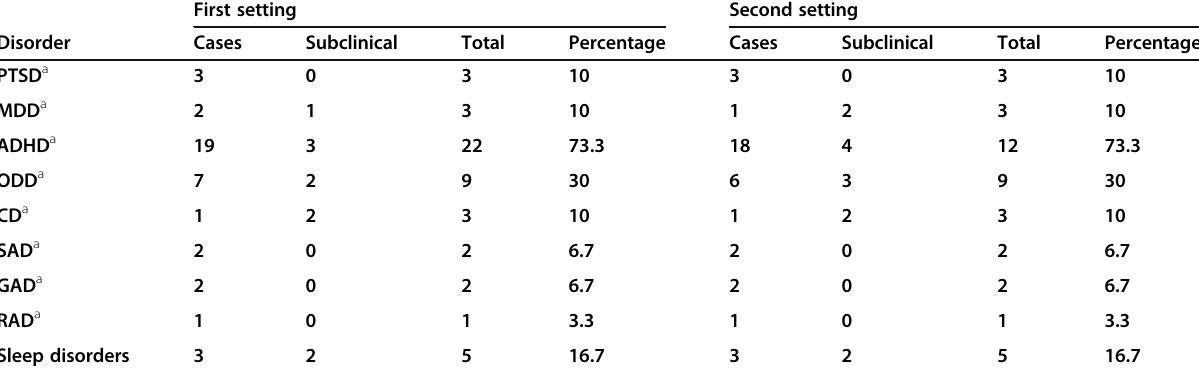
Table 2 Clinical characteristics of the study participants as diagnosed by DIPA a First setting